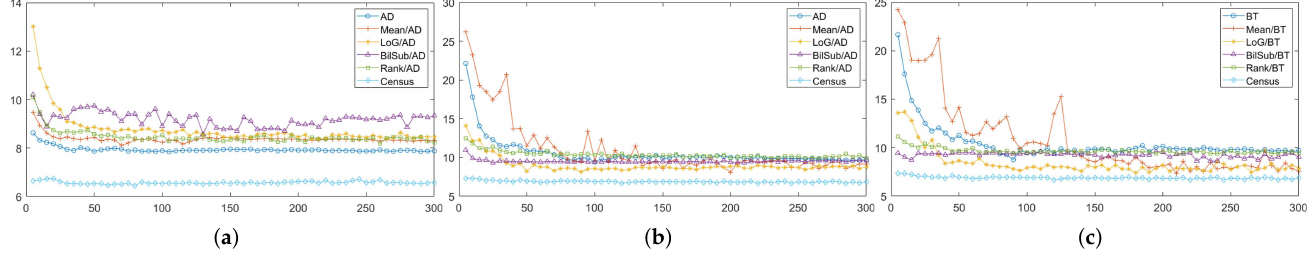
Figure 8. Errors of combinations of cost and image filter using the SGM and GC stereo methods, according to the variation of the pattern intensity parameter. ( a ) SGM/AD. ( b ) GC/AD. ( c )